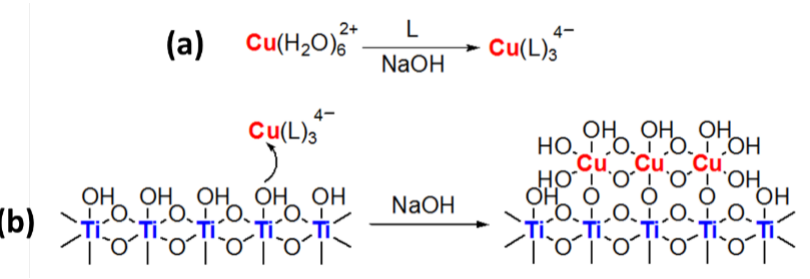
Figure16. Supposedcomplex-precipitationmechanism: ( a )complexation; ( b